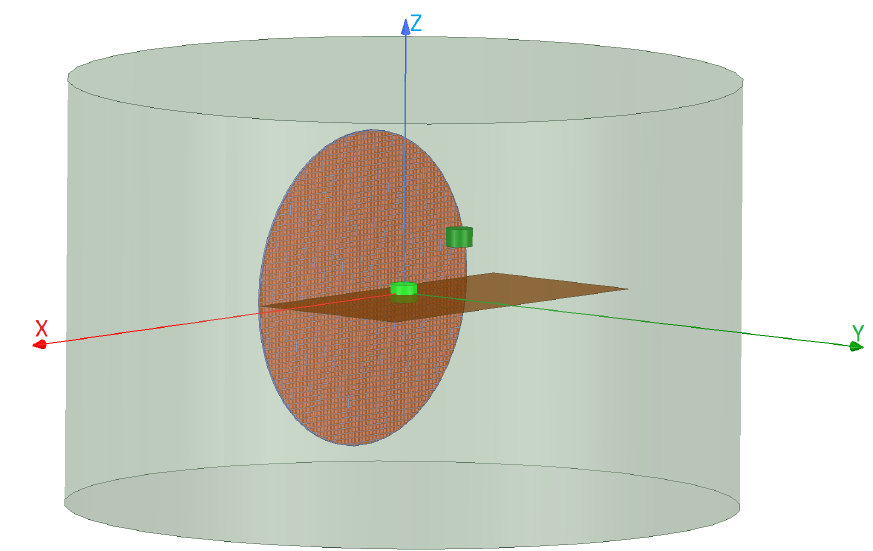
Figure 12. The simulated Bessel beam launcher setup. This represents Case IV where the light green circular cylinder (with the radius of λ /4 and the height of λ /3) represents the OI and the dark green circular cylinder, with the same size and dielectric properties as the OI, represents the undesired